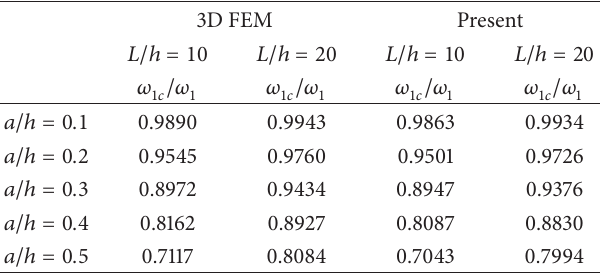
Table 4: The fundamental frequency ratio of cracked FGM beams with different crack